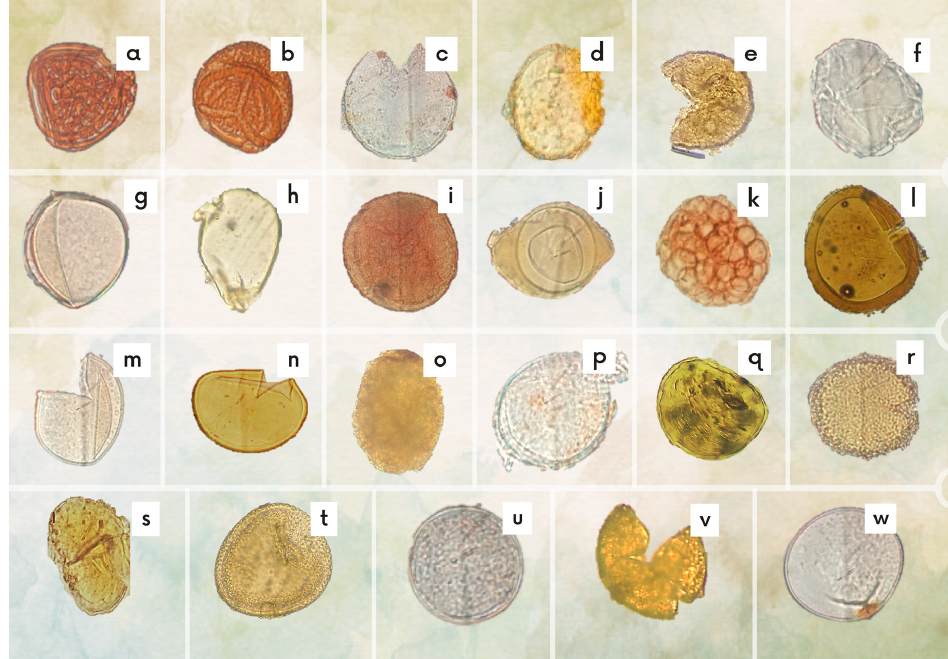
Figure 4. Genera of arbuscular mycorrhizal fungi in cocoa crops under semi-conservative cultiva- tion practice identified after a morphological analysis of spores: ( a , b ) Acaulospora , ( c – e ) Ambispora , ( f ) Intraspora , ( g , h ) Archaeospora , ( i ) Gigaspora , ( j – l ) Glomus , ( m – o ) Pacispora , ( p , q ) Paraglomus , ( r – t ) En- trophospora , ( u , v ) Diversispora , and ( w ) Scutellospora